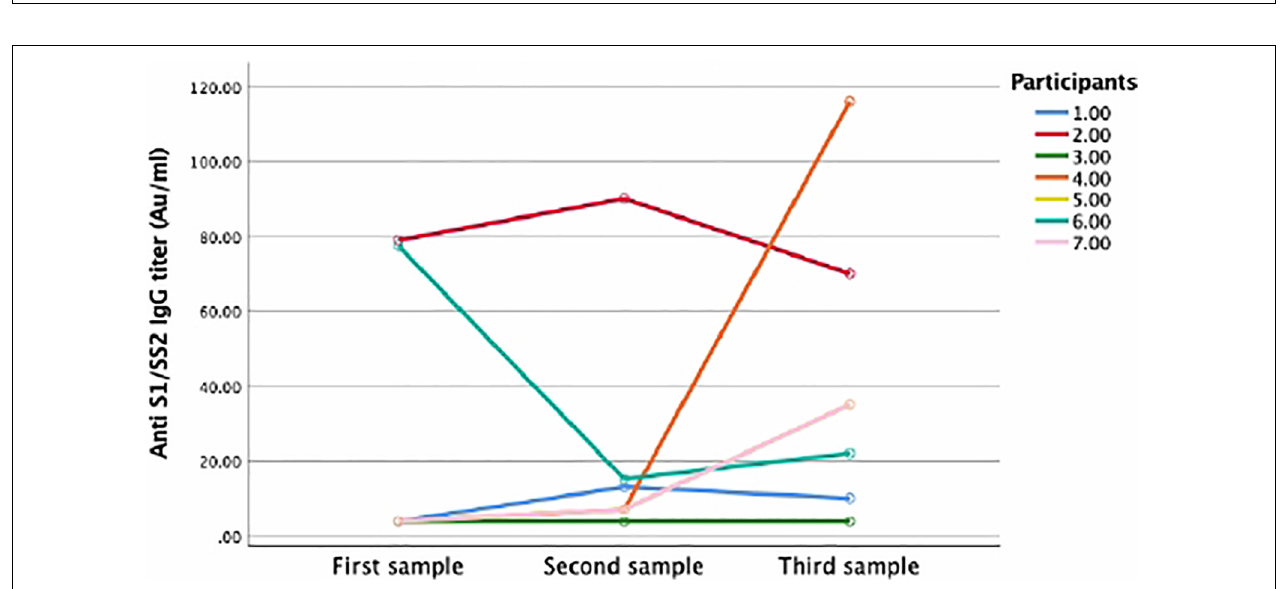
FIGURE 4 | Anti S1/S2 IgG dynamics in forty-six participants with two repeated serological samples. Line graph for 46 participants with two serological tests. Each line represents one participant. All participants who seroconverted in the first test remained positive in the second test. Majority of participants who tested negative in the first sample seroconverted in the second sample.